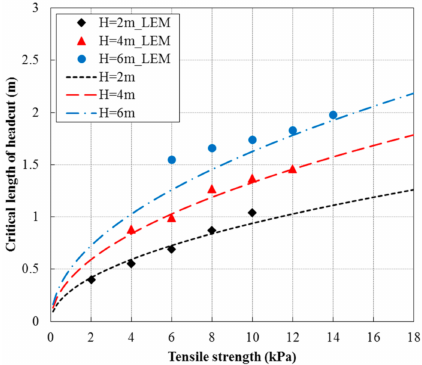
Figure 8. Comparison of the critical lengths of headcuts using the soil tensile strength based mathematical model and the simulated results calculated by the LEM (the limit equilibrium